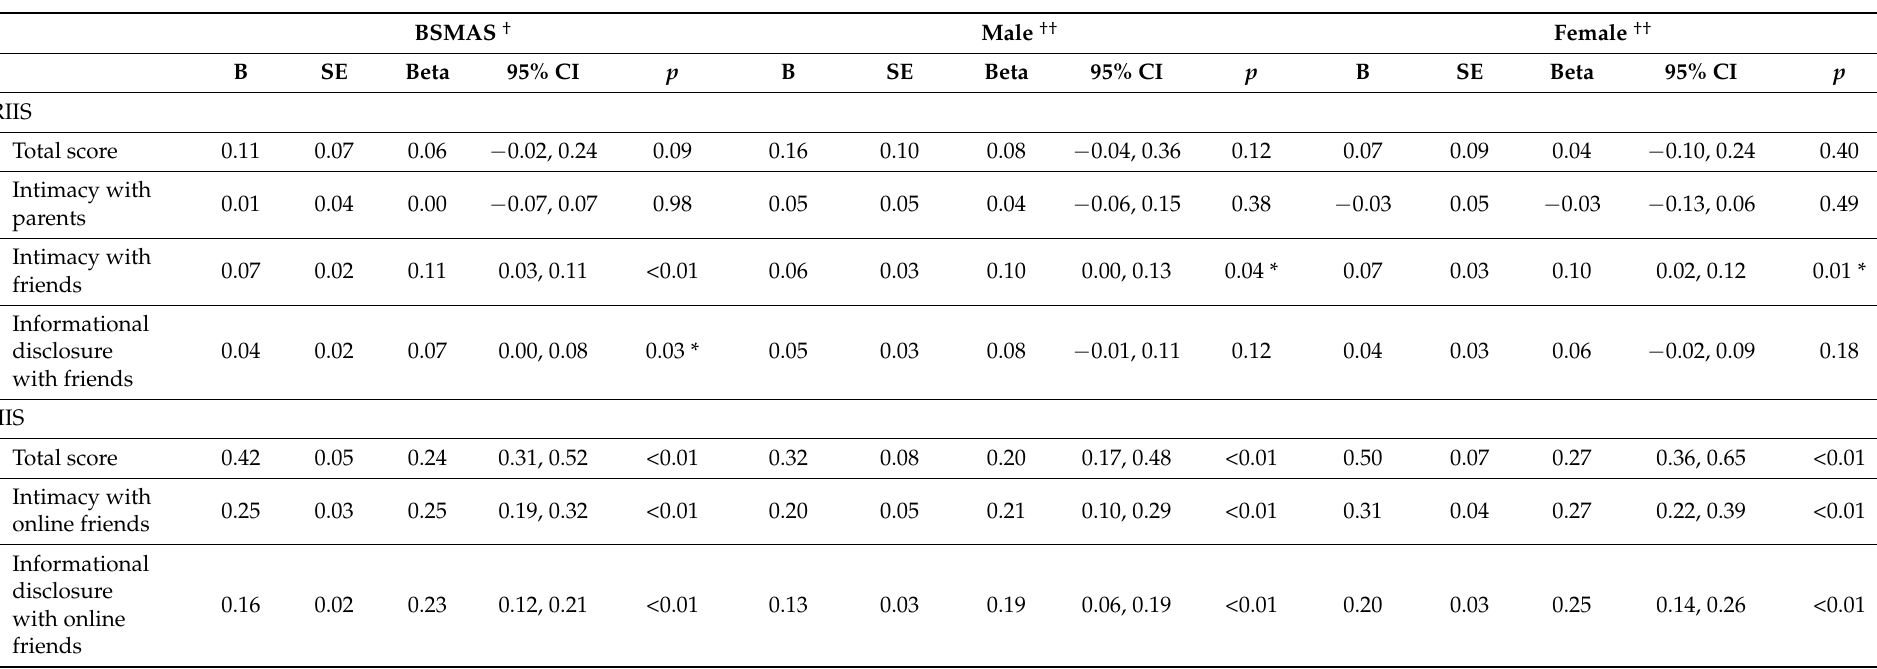
Table 4. Multiple regression analysis for identifying Real Interpersonal Interaction Scale (RIIS)/Internet Interpersonal Interaction Scale (IIIS) with their dimensions significantly related to Bergen Social media Addiction Scale